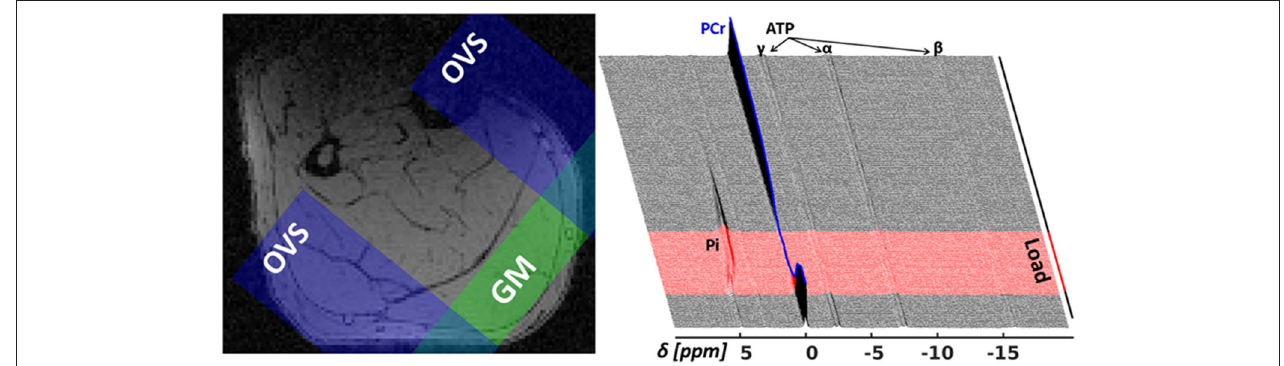
FIGURE 3 | Left : Transverse T 1 -weighted gradient-echo image (3D T 1 -weighted gradient-echo MRI, TR/TE = 10/6.15 ms) with selected 31 P-MRS slice in M. gastrocnemius medialis (GM, green area) and outer volume suppression bands (OVS, blue areas) selected to suppress signal contributions from adjacent tissue. Right : “Stack plot” of dynamic 31 P-MR spectra series from GM muscle. The spectra acquired during the 3min load phase (red graphs in the right chart) show rapid PCr decrease during the validation phase as well as a subsequent, significant resonance frequency shift of inorganic phosphate (Pi) due to a strong, anaerobic glycolysis related pH decrease. Please note that this paper focuses on the first steep decrease of PCr in the validation phase ( t <